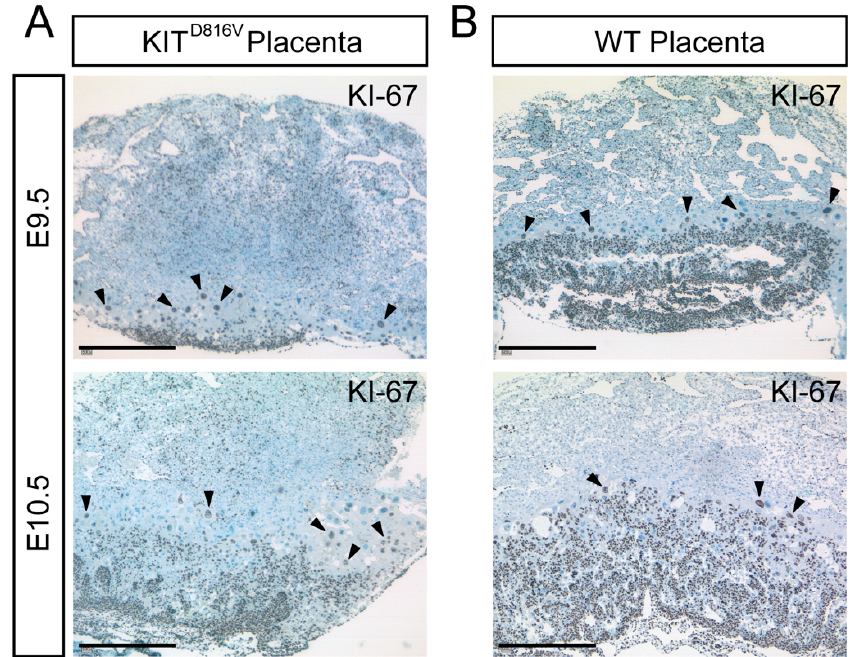
Figure 2. KIT D816V shows a reduced number of KI-67-positive cells. ( A , B ) Immunohistochemical staining of paraffin sections of KIT D816V and WT placentas for KI-67 at E9.5 and E10.5: Black arrowheads mark Parietal Trophoblast Giant Cells (P-TGCs) undergoing endoreduplication (biological replicates = 4; scale bar represents 500 μ m).